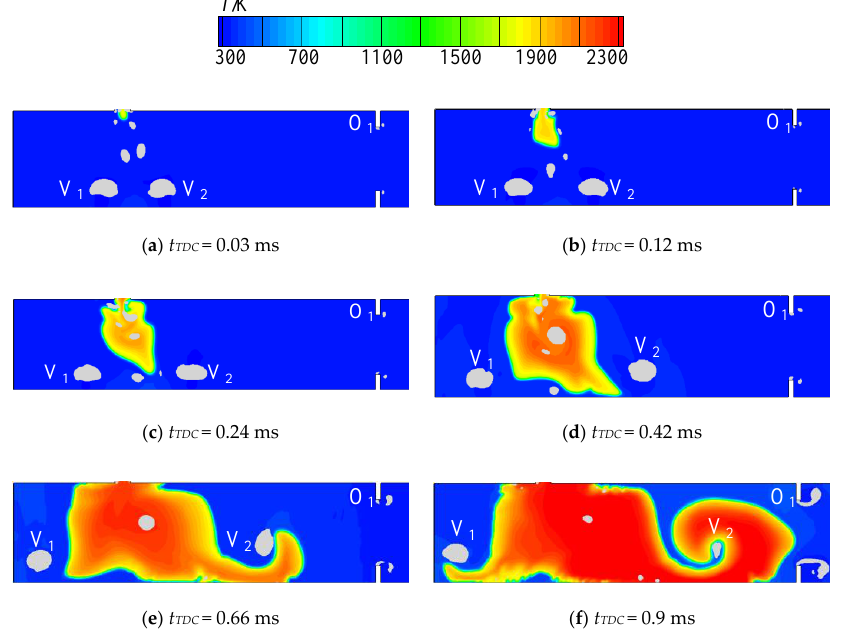
Figure 8. Interaction of jet flame and vortex in the detonation chamber.